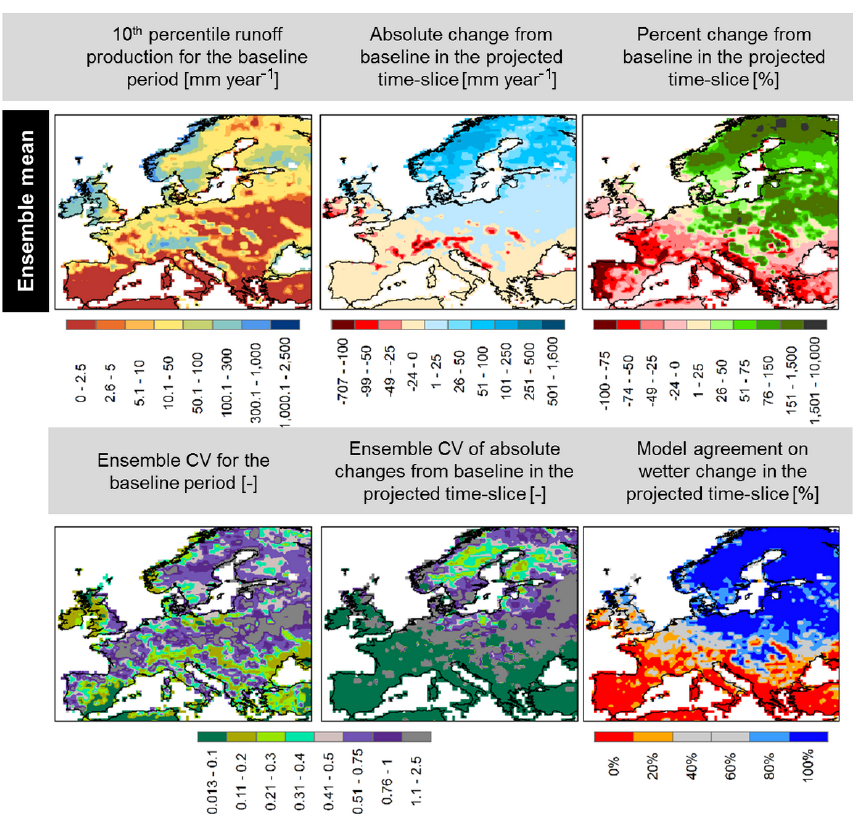
Figure 5. Ensemble mean of 10th percentile runoff production from Euro-CORDEX data bias adjusted against the WFDEI data set. Top row panels: 10th percentile runoff production derived on an annual basis averaged over the baseline period (1976–2005) (top row panels), absolute (middle row panels) and percent change (bottom row panels) in ensemble mean runoff in the + 4 SWL projected time slice. Bottom row panels: coefficient of variation of the ensemble members for the baseline period (left column panels), coefficient of variation of the projected absolute changes in the + 4 SWL projected time slice (middle column panels) and model agreement towards a wetter change in the + 4 SWL projected time